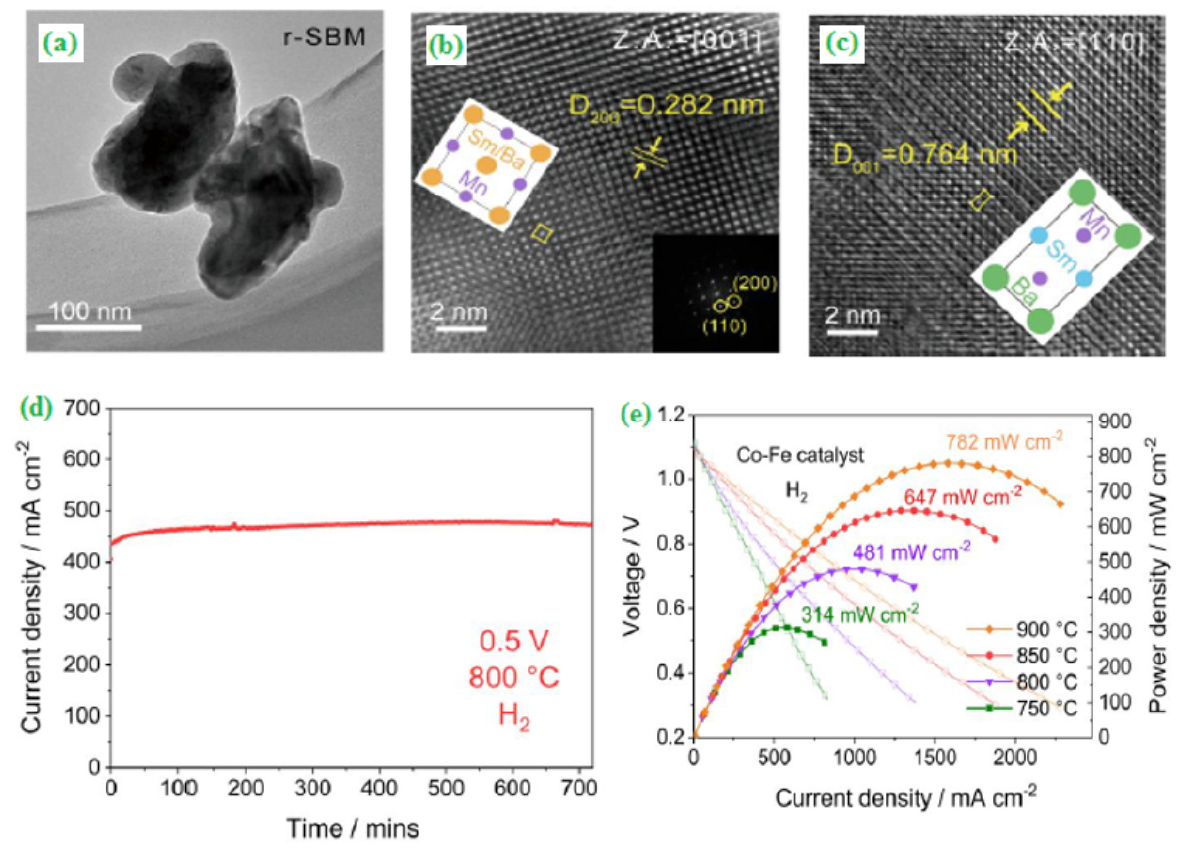
Figure 11. ( a ) TEM image of r–SBM, ( b ) Zone axis of 001 planes, ( c ) Zone axis of 110 planes, ( d ) Short term stability for the symmetrical cell under a constant voltage load of 0.5 V in humidified H 2 at 800 °C , and ( e ) Current-voltage and power density curves for the symmetrical SBM electrode in the presence of humidified H 2 , anode side infiltrated with 15 wt% Co–Fe catalysts. Copyright 2019 by American Chemical Society [94].